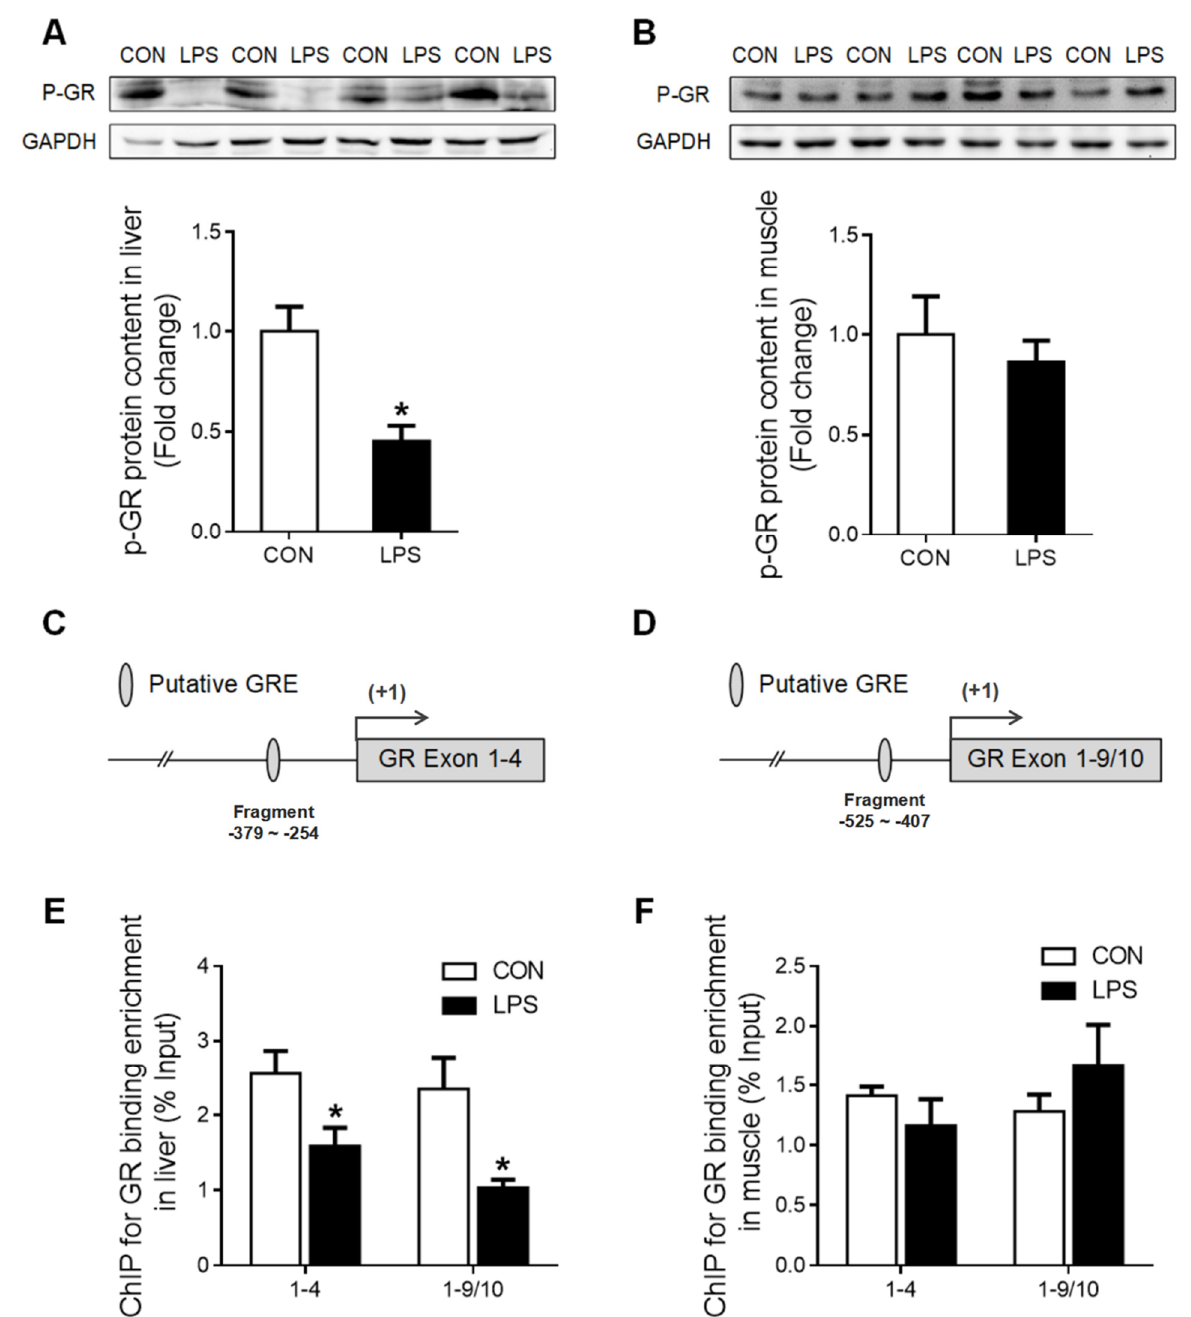
Figure 4. The change of p-GR and GR binding with its promoter in liver and muscle under LPS treatment. ( A ) Western blot and densitometric analyses of p-GR and GAPDH proteins in the liver. ( B ) Western blot and densitometric analyses of p-GR and GAPDH proteins in muscle. ( C ) The putative fragment GRE site on the promoter region of GR exon 1–4. ( D ) The putative fragment GRE site on the promoter region of GR exon 1–9/10. ( E ) ChIP analyses GR binding to GRE sites on the promoter of GR exon 1–4 and 1–9/10 in the liver. ( F ) ChIP analyses p-GR binding to GRE sites on the promoter of GR exon 1–4 and 1–9/10 in muscle. Values were expressed as means ± SEM, n = 4 in each group, * p < 0.05.